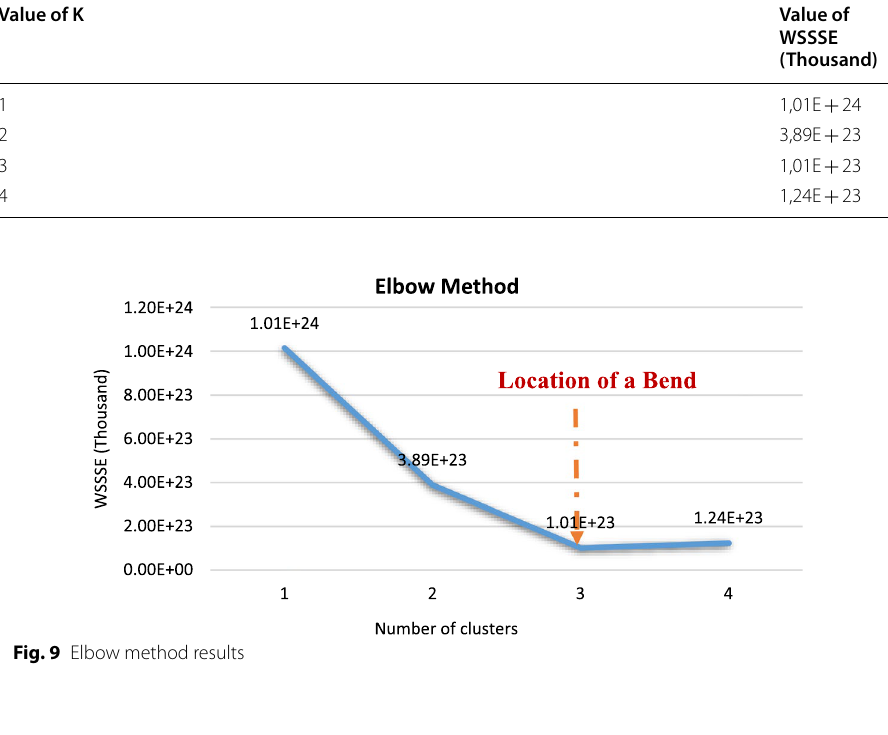
Table 8 Values of WSSSE for different values of K Value of